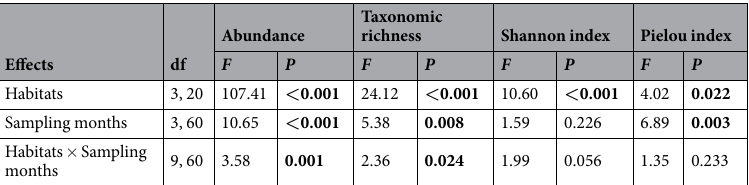
Table 3. Repeated-measures ANOVA results for the effects of habitats, sampling months and their interactions on the abundance and diversity of the soil nematode community. Statistically significant ( P < 0.05) results are shown in boldface (n =